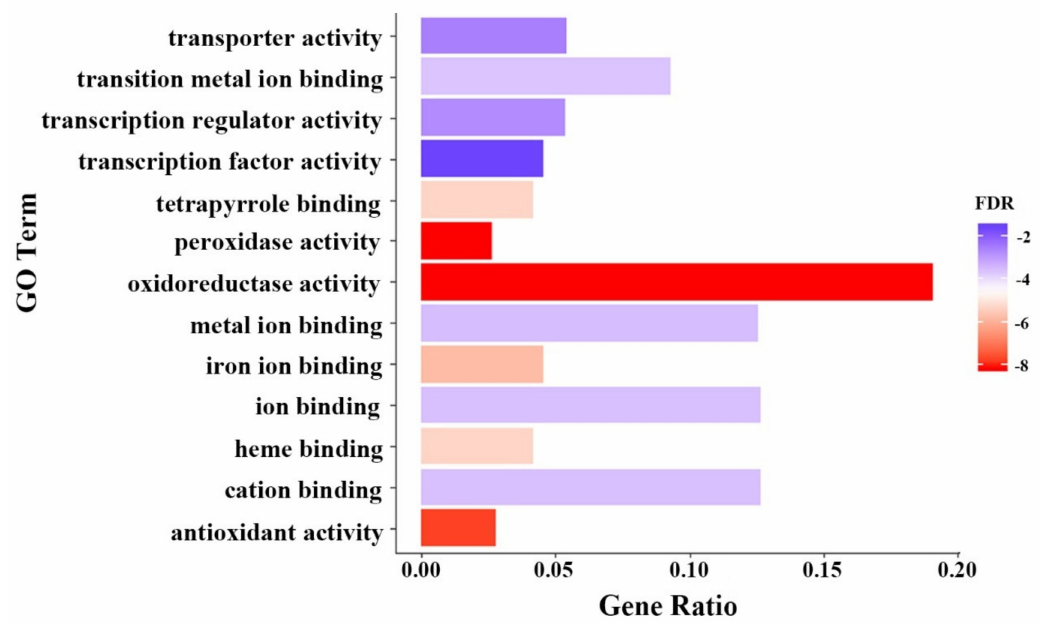
Figure 2. Gene Ontology (GO) enrichment analysis (molecular function) of the 1411 up-regulated candidate genes for Al tolerance in soybean. The gene ratio on the x -axis represents the percentage of genes in each category. The Singular Enrichment Analysis (SEA) was performed using AgriGO. The GO terms and significance levels are displayed. Only the significant ( p < 0.01, FDR < 0.05) GO terms are displayed. FDR: False discovery rate, which is shown as the logo on the right ranging from the lowest FDR (in red) to highest FDR (in